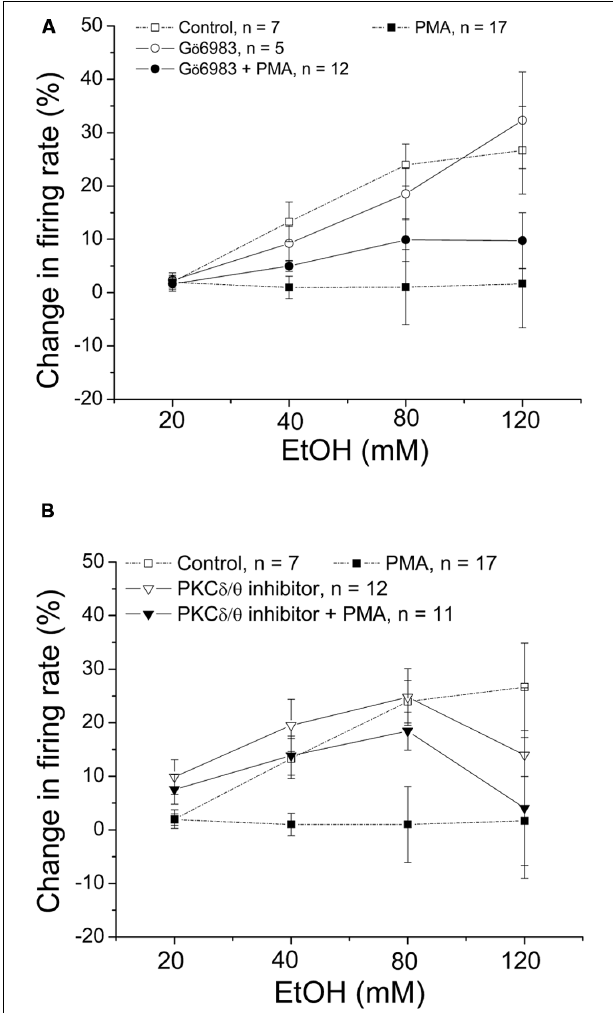
FIGURE 4 | PKC δ / θ inhibitor, but not Gö6983, inhibits PMA suppression of ethanol excitation. Percentage change in firing rate (mean ± SEM) in response to ethanol application in different conditions is plotted as a function of time.The effect of ethanol alone ( (cid:2) ), and ethanol in the presence of PMA ( (cid:3) ) from Figure 1C are shown for comparison. (A) With Gö6983 (10 μ M) and PMA (1 μ M) in the recording pipette, ethanol did not cause a significant increase in firing rate at any concentration ( • , n = 12; one-way repeated measures ANOVA, F ( 3,33 ) = 2.26, p > 0.05).With Gö6983 (10 μ M) alone in the recording pipette, a significant increase in firing rate produced by increased concentrations of ethanol was observed ( o , n = 5; one-way repeated measures ANOVA, F ( 3,12 ) = 10.97, p < 0.05). (B) With PKC δ / θ inhibitor (700 nM) and PMA (1 μ M) in the recording pipette, increasing concentrations of ethanol caused significant excitation ( (cid:4) , n = 8; one-way repeated measures ANOVA, F ( 3,21 ) = 3.78, p < 0.05). Similarly, a significant, concentration-dependent increase in firing rate was produced ethanol with PKC δ / θ inhibitor (700 nM) alone in the recording pipette ( ∇ , n = 11; one-way repeated measures ANOVA, F ( 3,30 ) = 19.36, p <